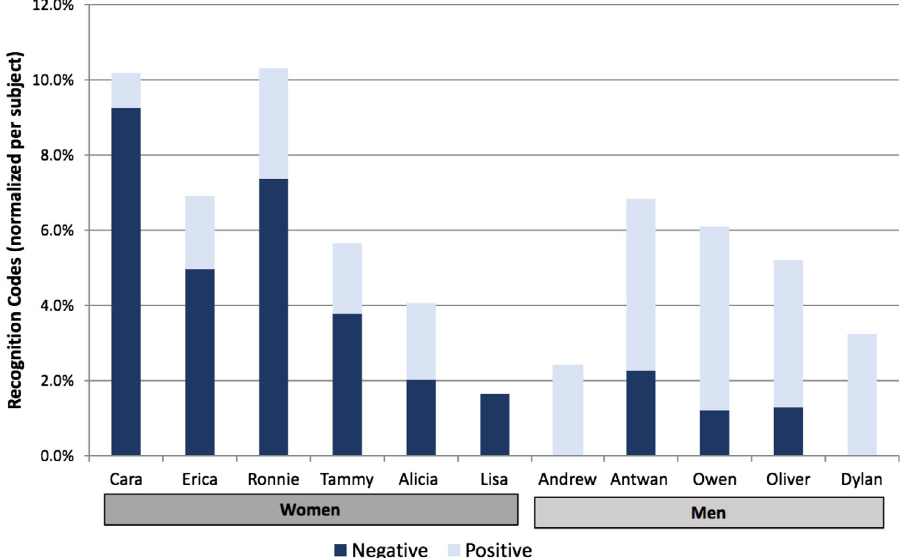
FIG. 5. Breakdown of external recognition for men (to the right) and women (to the left) in our sample, normalized to the total code counts for each individual interview. The dark blue bar represents the percentage of negative external recognition, and the light blue represents the percentage of positive